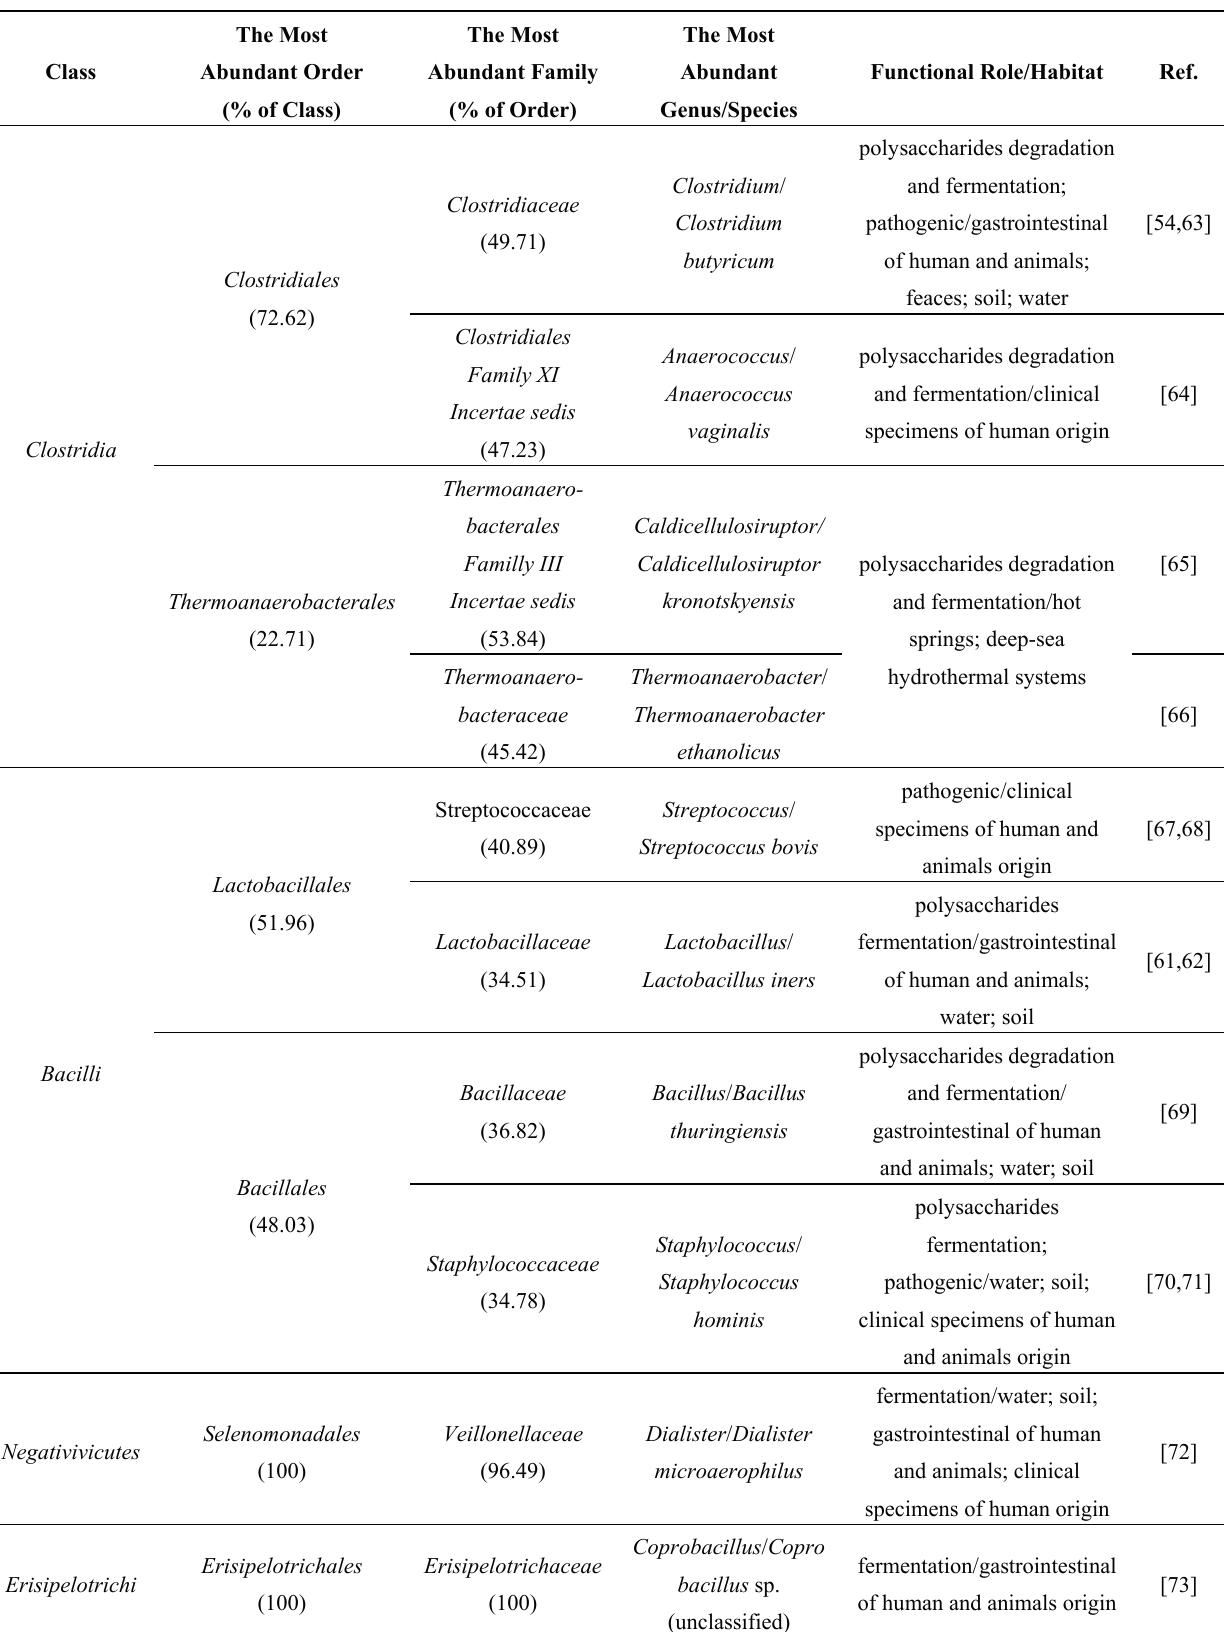
Table 2. Categorization and predicted function of members of the phylum Firmicutes